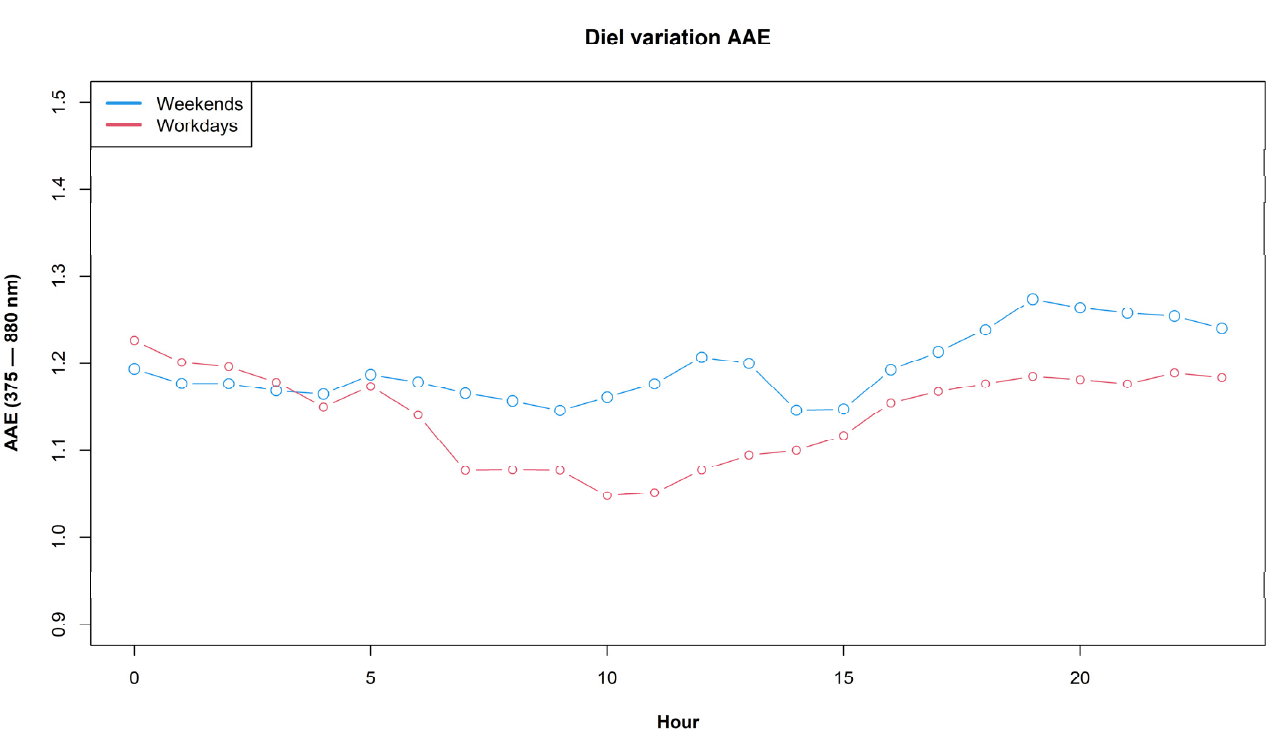
Figure 3. Diel profiles of AAE for workdays and weekends.